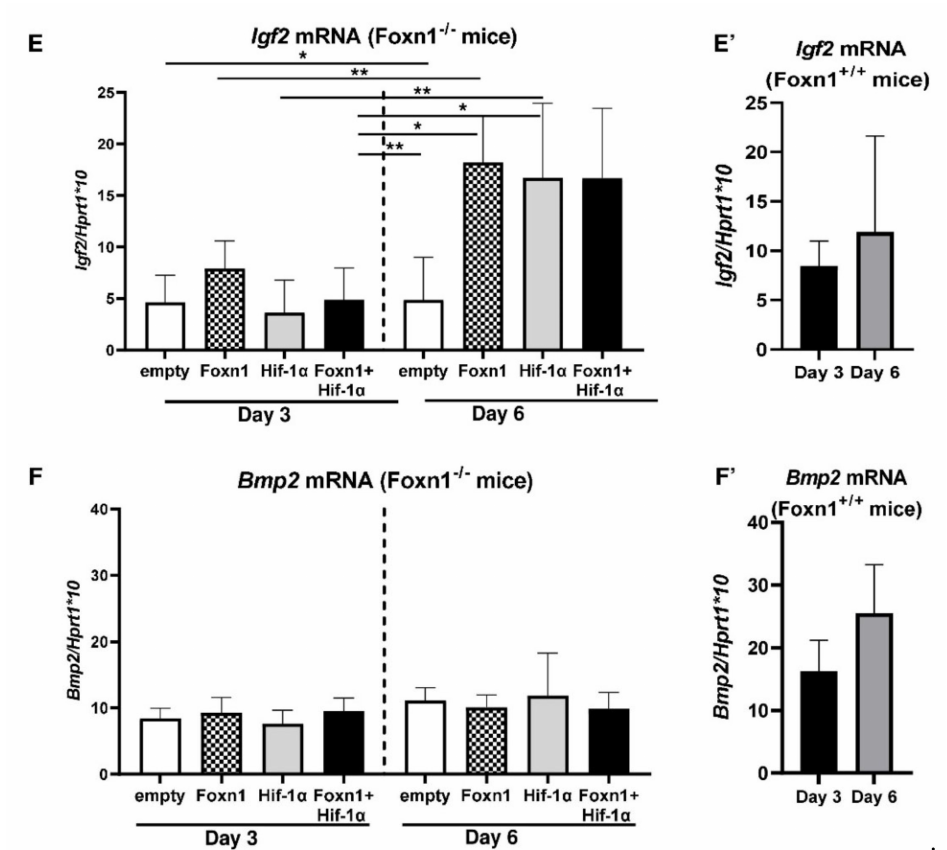
Figure 6. Quantitative RT-PCR mRNA expression analysis of adipogenic-related genes in the skin of Foxn1 − / − mice injected with LV-empty, LV-Hif-1 α , LV-Foxn1 or LV-Hif-1 α +LV-Foxn1 ( A – F ) and Foxn1 +/+ (Balb/c) mice ( A’ – F’ ): Zfp423 ( A , A’ ); Ppar γ ( B , B’ ); Mest ( C , C’ ); Fabp4 ( D , D’ ); Igf2 ( E , E’ ); and Bmp2 ( F , F’ ). Values are the mean ± SD, n = 4 mice per group/per time point. Asterisks indicate significant differences (* p < 0.05; ** p <